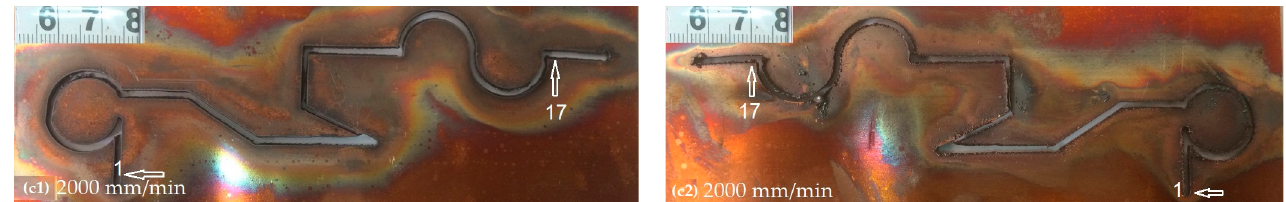
Figure 6. The cutting path widths of ( c1 , c2 ) at 2000 mm/min at 30 A for Point 1.